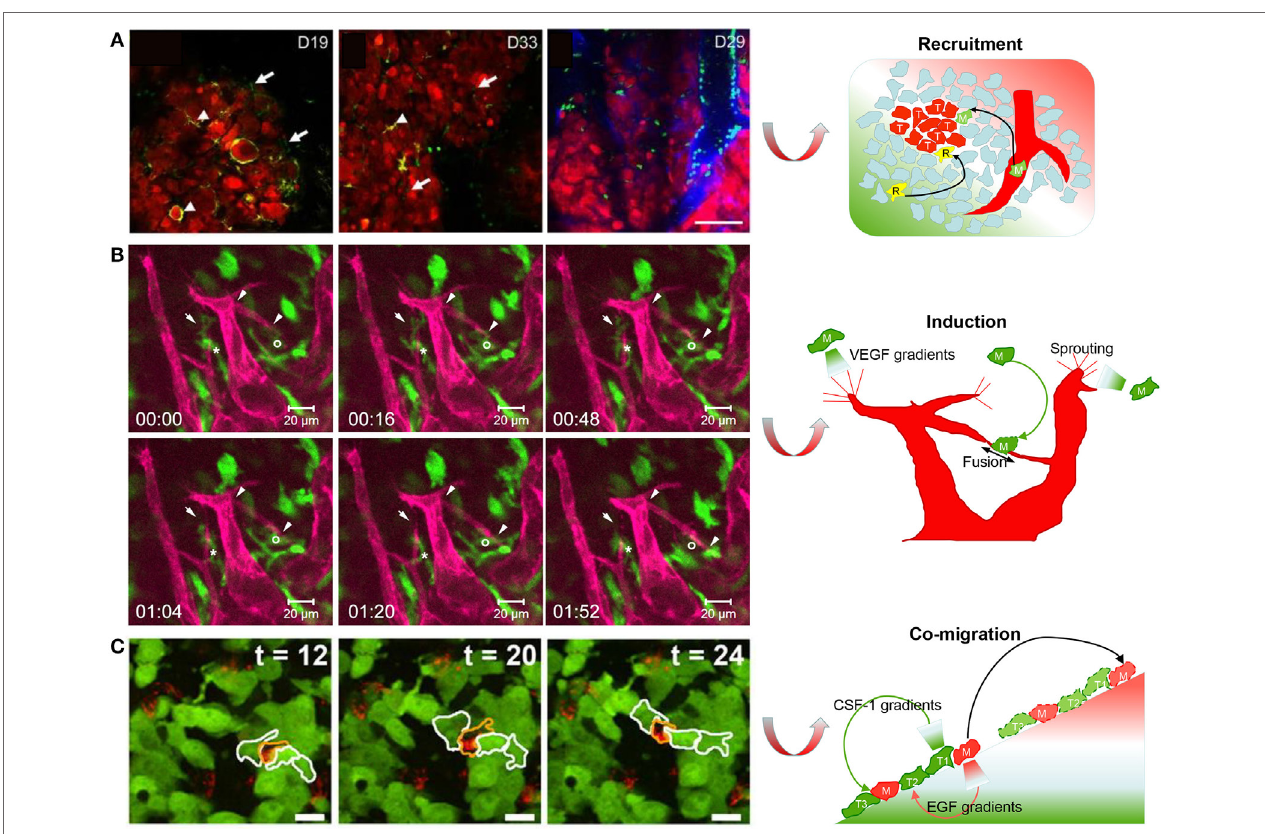
FiGURe 2 | Imaging macrophages in the context of cancer. (a) Live imaging on mouse tumor showed that resident CD11c-EYFP + microglia ( R ) were gradually replaced by EGFP + /EYFP + monocyte-derived macrophages ( M ) and dendritic cells with glioma development (reproduced under the terms of the CC BY 4.0 license, Copyright © 2016 Springer Nature.) (68). (b) Live imaging in mouse cornea showed that one enhanced green fluorescent protein (EGFP)-labeled macrophage ( M )-guided mCherry-labeled endothelial branch elongation by promoting endothelial tip cell sprouting [reproduced under the terms of the CC BY 4.0 license, Copyright © 2015 Hsu et al. (73)]. (C) Texas red dextran-labeled macrophages ( M ) co-migrated with EGFP-expressing tumor cells ( T ) as part of a migratory stream according to live imaging in vivo [reproduced with permission from Ref. (78), Copyright © 2011 the Company of Biologists